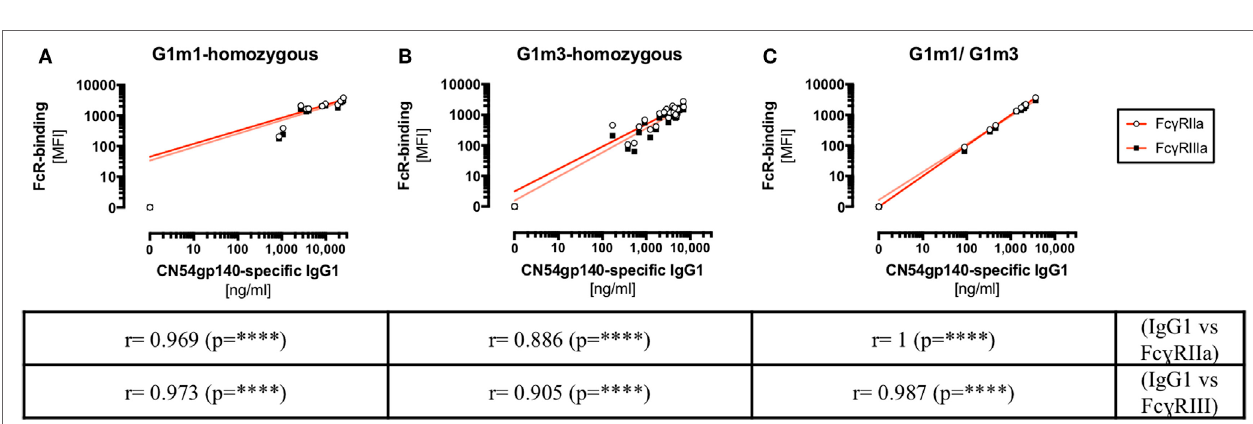
FigUre 4 | HIV-specific IgG1 levels ( x -axis) correlate with Fc-receptor binding in X001 study participants. Correlation analysis for X001 study participants across all study time-points. (a) homozygous G1m1-carriers, (B) homozygous G1m3-carriers, and (c) individuals heterozygous for G1m1/G1m3. Below the graph Spearman’s rank correlation coefficient r -values are shown (**** p < 0.0001). MFI, median fluorescence intensity.